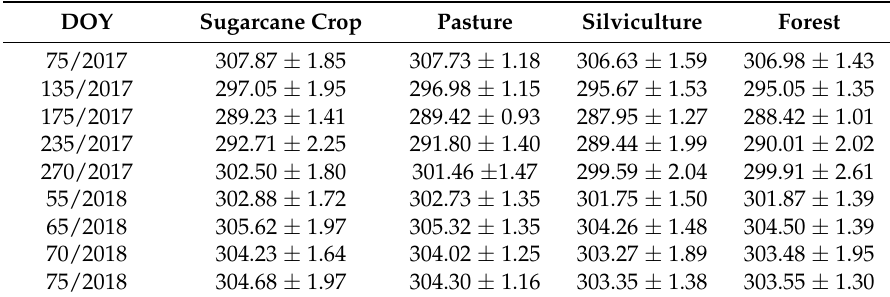
Figure 7. Surface temperature (K) at a daily scale between 2017 and 2018 in watersheds with varied land use. (DOY = day of year). Table 3. Mean values and standard deviation at a daily scale of surface albedo between 2017 and 2018 by land use and day of year (DOY).